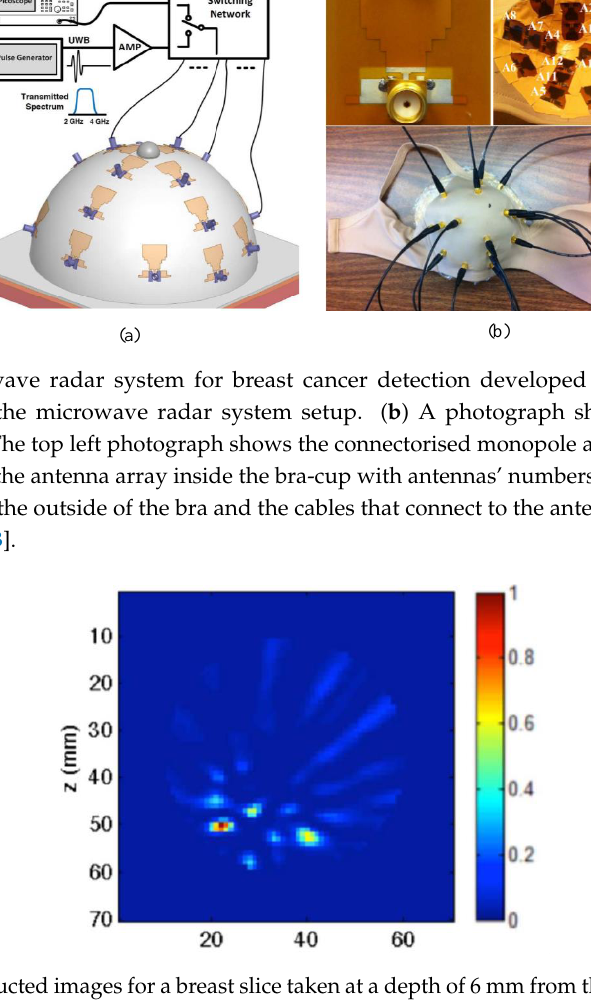
Figure 28. Reconstructed images for a breast slice taken at a depth of 6 mm from the chest wall obtained using the system developed by Porter et al. [83]. Reprinted with permission from